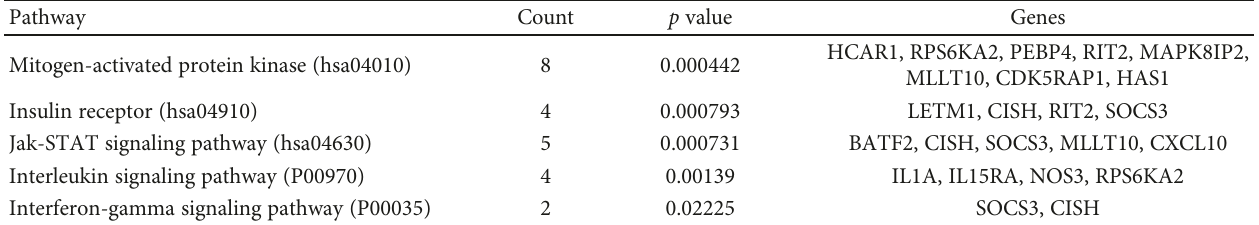
Table 2: Enriched pathways for the upregulated genes in PMNs phagocytizing iRBCs. Pathway Count Mitogen-activated protein kinase